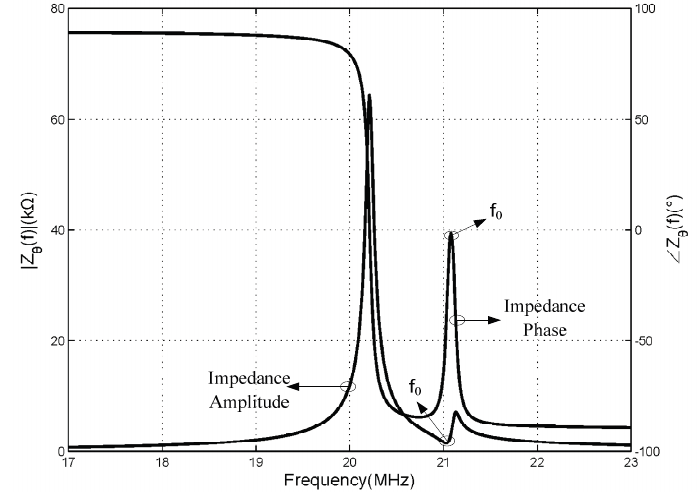
Figure 3. Magnitude and phase of input impedance for a LC